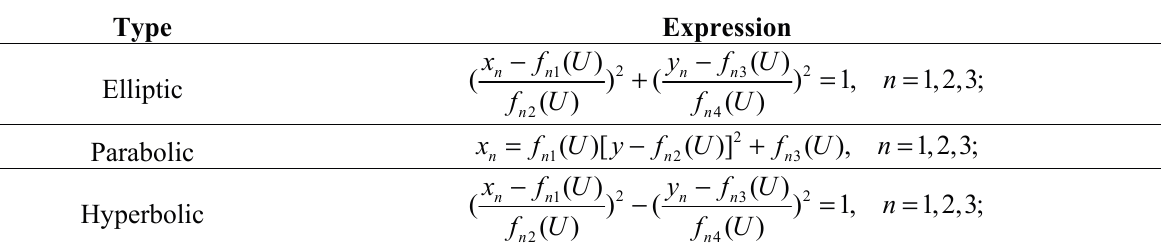
Table 1. Possible types of conic